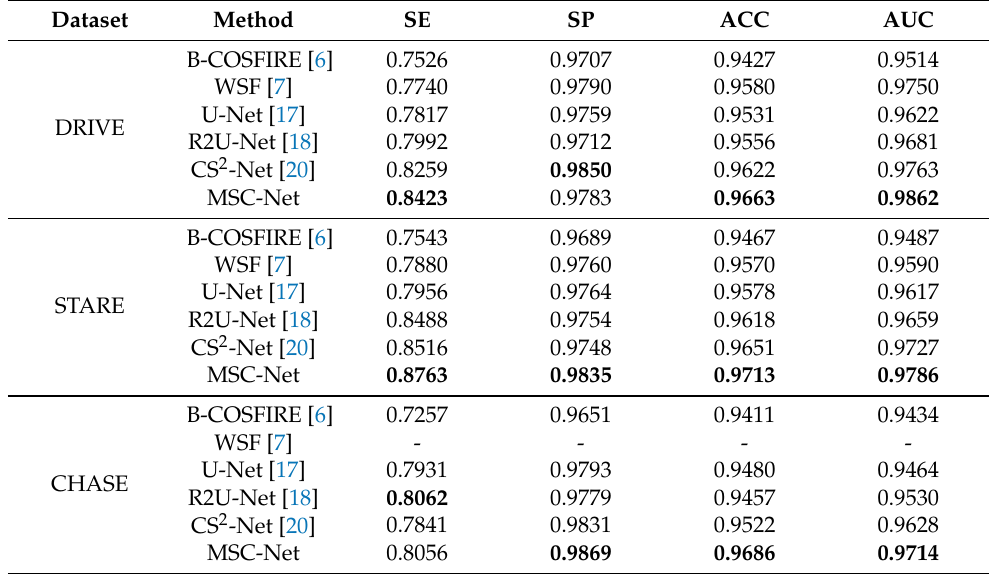
Table 3. SE, SP, ACC, and AUC scores of MSC-Net and other baseline methods for vessel segmentation task on the test